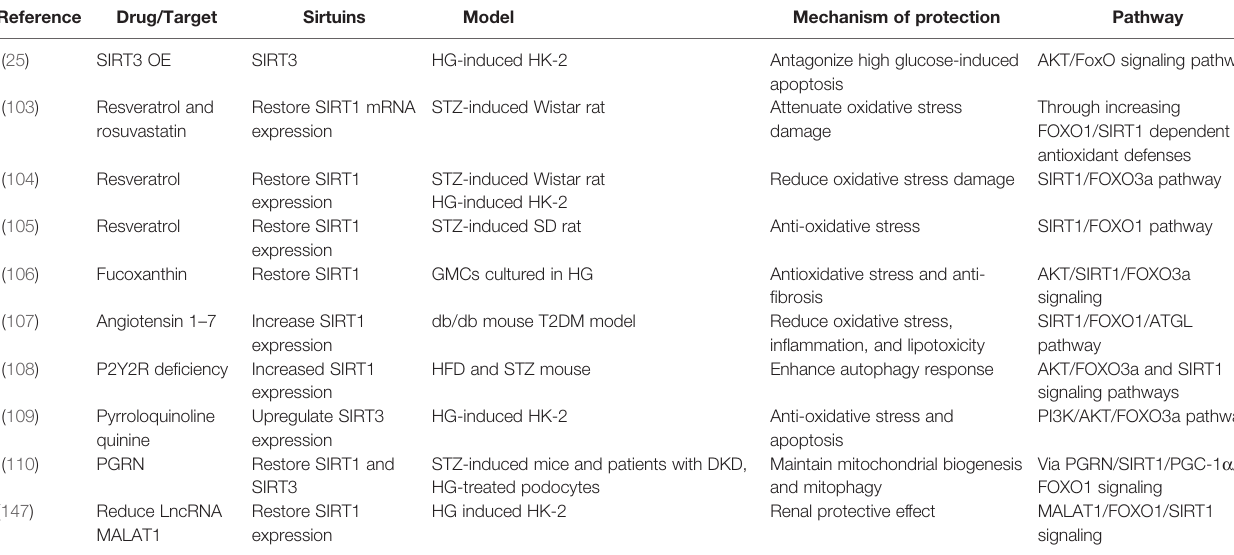
TABLE 6 | DKD studied on PI3K/AKT/FOXO3 pathway.